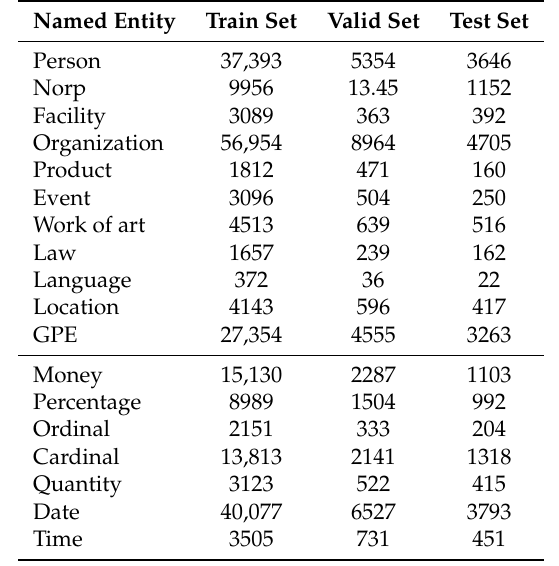
Table 2. Statistics of named entities in OntoNotes 5.0 found in the training, development, and test sets. In OntoNotes 5.0, the highest proportion is organization, followed by person and Geopolitical Entity